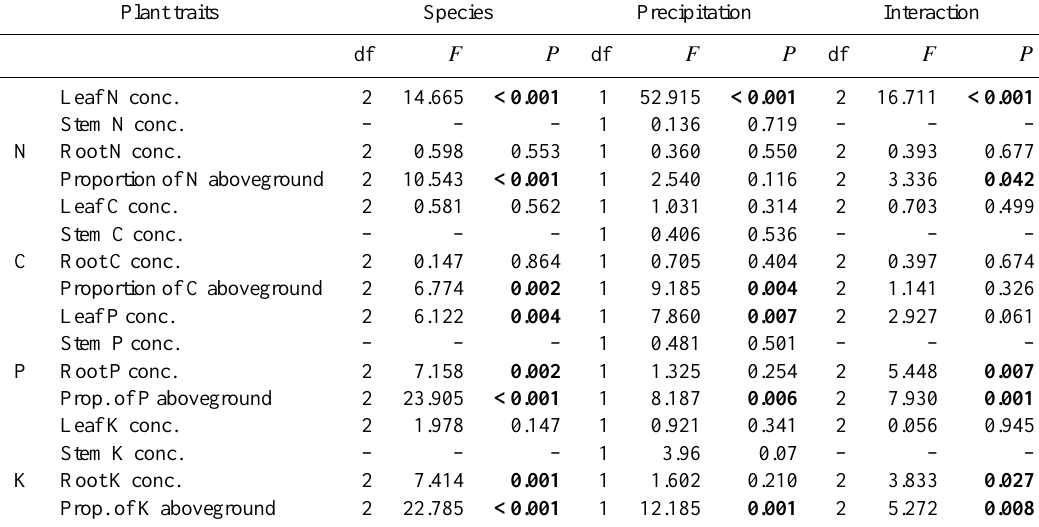
Table 1. Effects of species and mean annual precipitation on each plant trait in the two transects. Bold values indicate P <0.05. Plant traits